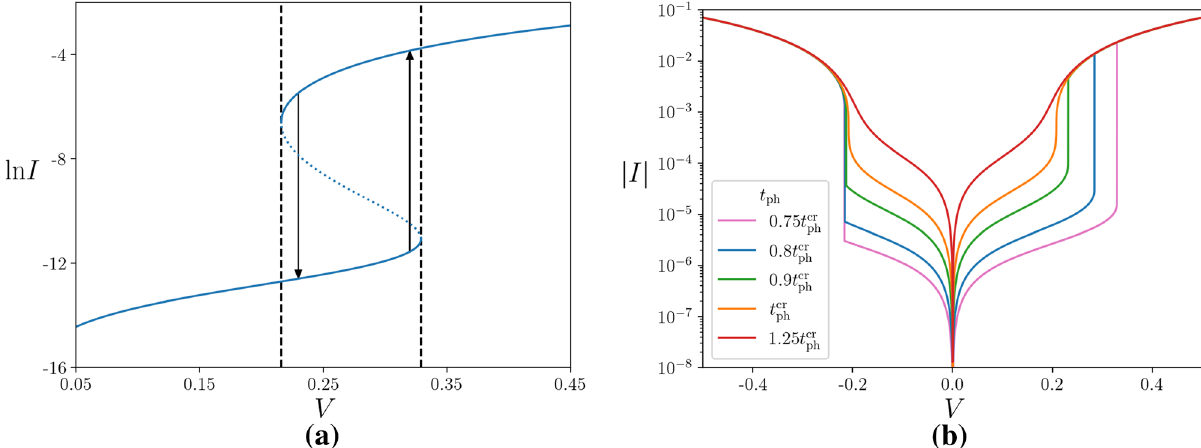
Figure 3. (a) The S -shape solution to the equation for the non-linear conductance, Eq. (10), for t ph = 0.75 t cr ph . The dotted part corresponds to unstable states, resulting in hysteretic jumps, denoted by the arrows. Note that the jumps do not necessarily occur at the boundaries of the bistability (dashed lines). (b) The numerically predicted I - V characteristics for various lattice temperatures. The jumps here are shown to be at the bistability boundaries, though this may not be the case in reality. The V > 0 side of the graph illustrates the transition from the cold electron (low conductance) state to the hot electron (high conductance) state, which occurs when the source-drain voltage is increased. The V < 0 side displays the opposite transition when the voltage is decreased, going from the hot to cold electron states. In both (a) and (b) the voltage is measured in units of V 0 and the current is in units such that the resistance is measured in units of R 0